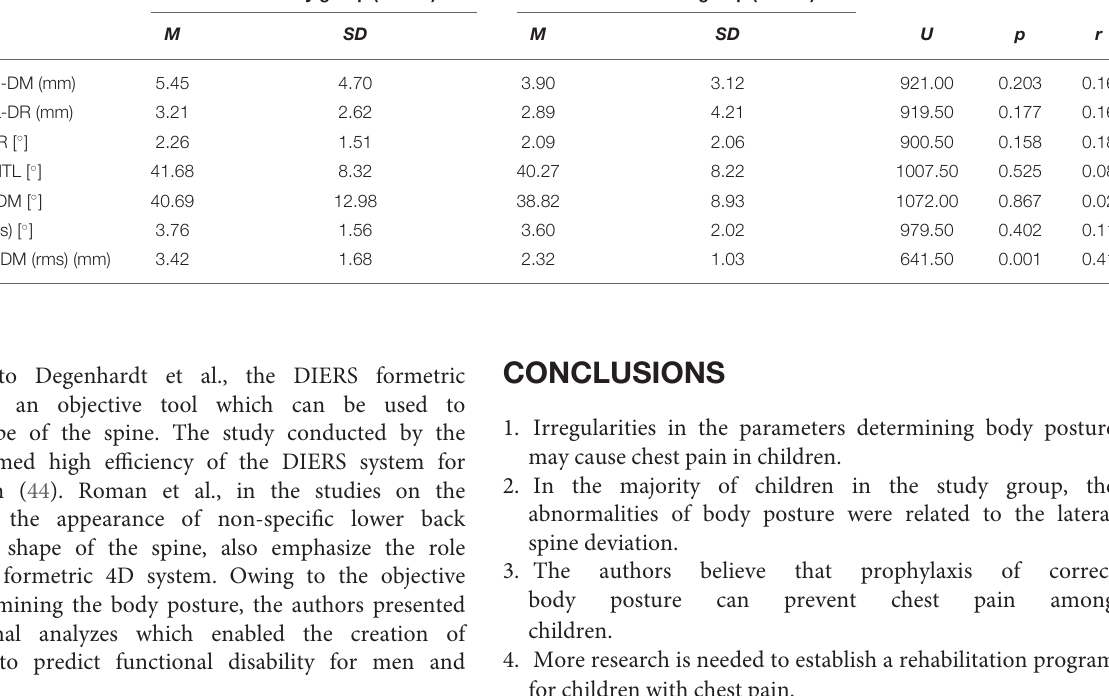
TABLE 6 | Mean scores, standard deviations and the significance of differences in body posture indicators in children aged 11–12 years, depending on the occurrence of chest pain. Children from study group ( n = 30) Children from control group ( n = 73) M